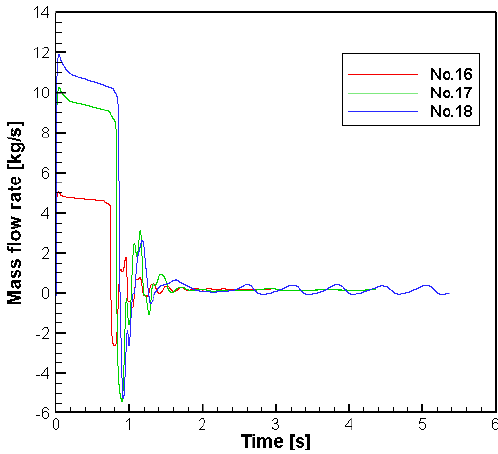
Figure 16. Mass flow rates of a water inlet in different cases.